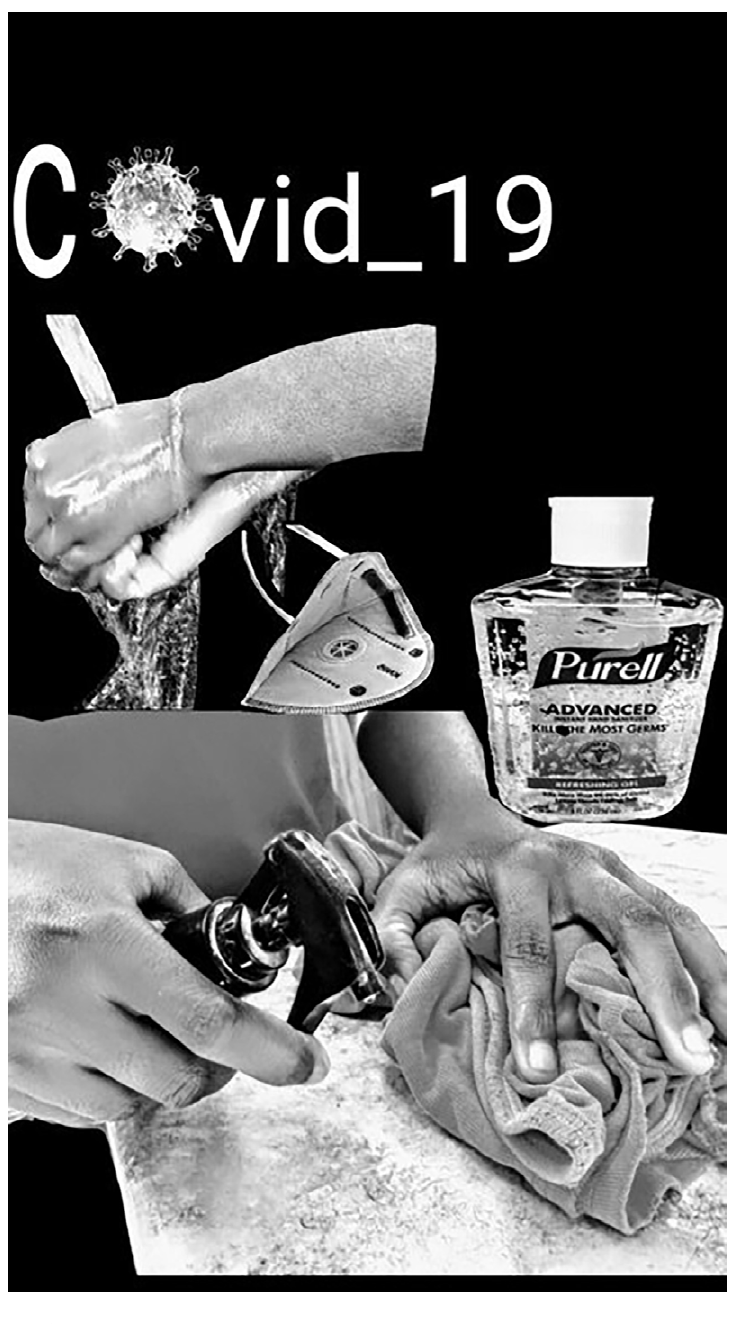
Figure 4. ‘Covid- 19’ by Dineo